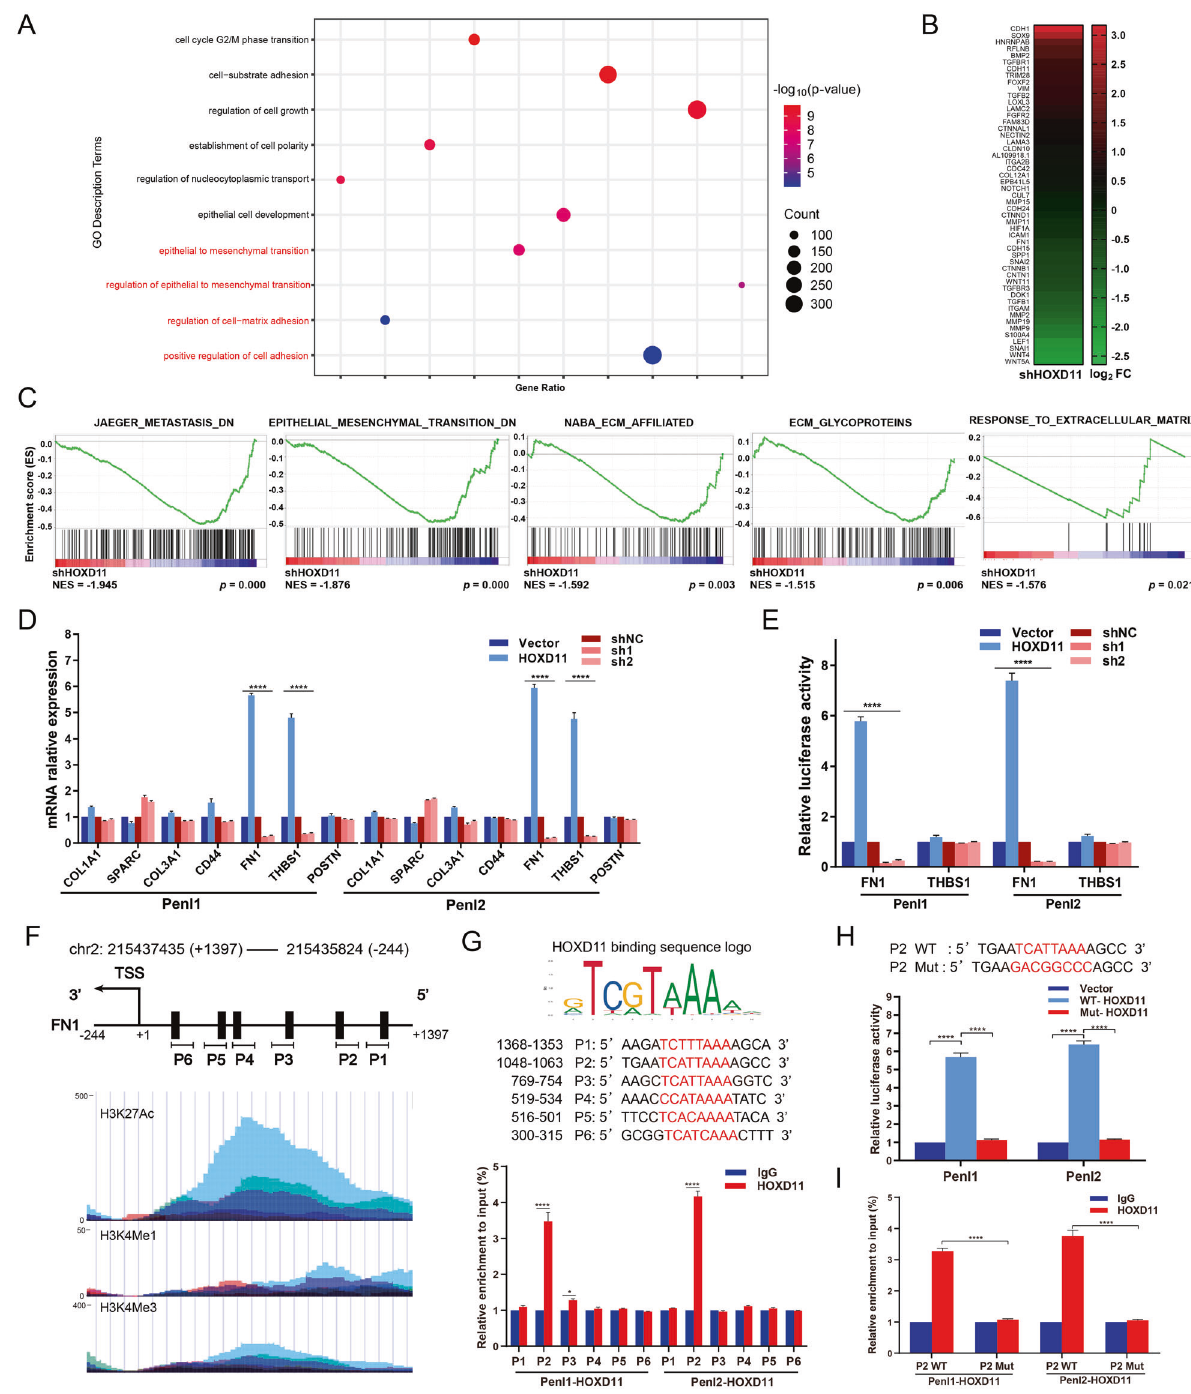
Fig. 5 HOXD11 directly bounded with the promoter of FN1 in PSCC. A GO enrichment analyses between Penl2 HOXD11-shNC and HOXD11- sh1 cells indicated the signi fi cant genes enrichment involving in tumor progression. B The differential genes involving in EMT and cell adhesion are shown by heatmap. C GSEA analysis showed that knockdown of HOXD11 might promote EMT and tumor metastasis through the degradation of ECM. D qPCR analysis of ECM-related markers in the indicated cells. E Luciferase reporter assay of FN1 and THBS1 transcriptional activity. F Six potential FN1 promoter binding regions with HOXD11 were predicted by JASPAR database. The chromatin stabilization of corresponding regions were detected by H3K27Ac, H3K4Me1 and H3K4Me3 by UCSC Genome Browser. G Detail nucleotide binding sequences of FN1 promoter and the CHIP-seq results. H , I Luciferase reporter and CHIP-seq assays indicated that FN1 transcriptional activity was eliminated when transfection with FN1 promoter with mutant nucleotide binding sequences of P2 sites. * p < 0.05; ** p < 0.01; *** p < 0.001; **** p < 0.0001. KEGG, Kyoto Encyclopedia of Genes and Genomes; GO, Gene Ontology; GSEA, gene set enrichment analysis; EMT, epithelial-mesenchymal transition; ECM, extracellular matrix; CHIP, chromatin immunoprecipitation.